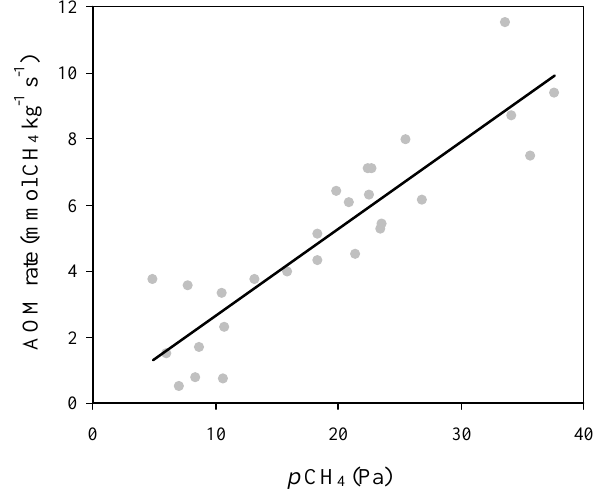
Fig. 2. Porewater CH 4 concentration dependent rates of AOM. Line